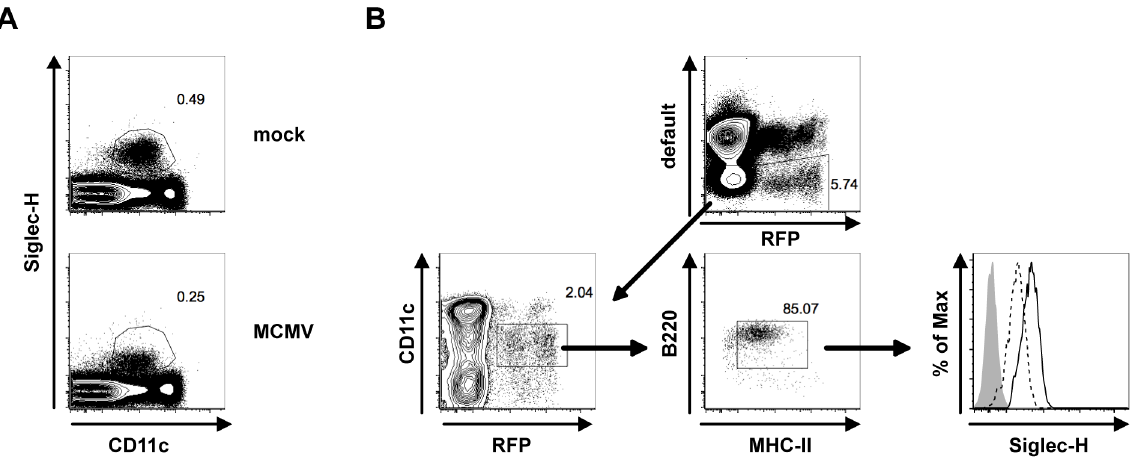
Figure 2. Siglec-H is downregulated upon MCMV infection invivo . pDCre x RFP mice were infected with 5 6 10 4 PFU MCMV in vivo . ( A ) Representative FACS plots show CD11c versus Siglec-H of live splenocytes at 36 h p.i. ( B ) Gating strategy showing exclusion of B-, T-, NK-T, and NK cells by CD19, CD3 e , NK1.1 in a default channel. RFP + pDCs were gated as CD11c int B220 + MHCII int to exclude MHCII 2 DC precursors. Histogram overlays show RFP + pDCs from mock (bold line) and MCMV infected (dashed line) pDCre x RFP mice at 36 h p.i. Isotype staining is displayed as grey histogram. Data are representative of 2 independent experiments using 4–5 mice with comparable results.